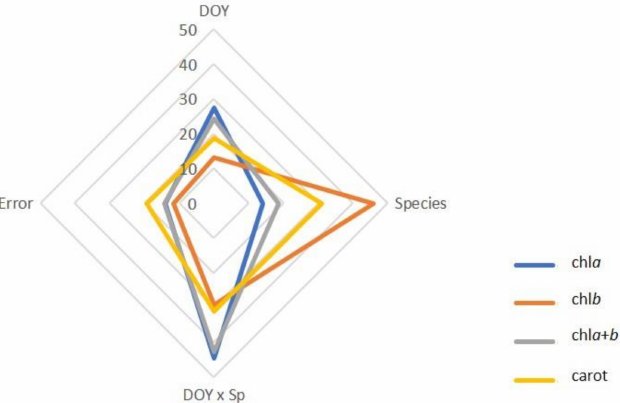
Figure 3. Proportion of the total variance in chlorophyll a (chl a ), chlorophyll b (chl b ), total chlorophyll (chl a + b ), and carotenoids (carrot) by sources of variation (DOY, Species, DOY × Sp, and